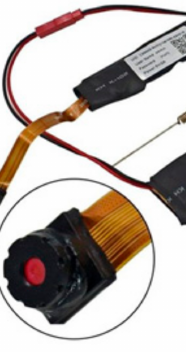
Figure 13. Mini Wi-Fi IP